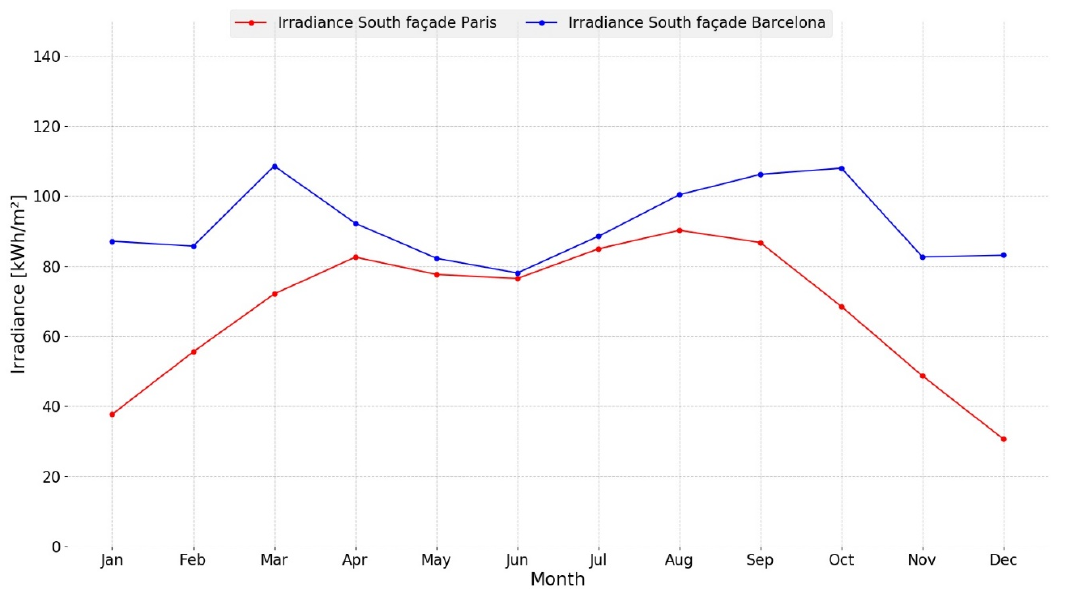
Figure 5. Monthly irradiances and mean temperatures for Barcelona and Paris.